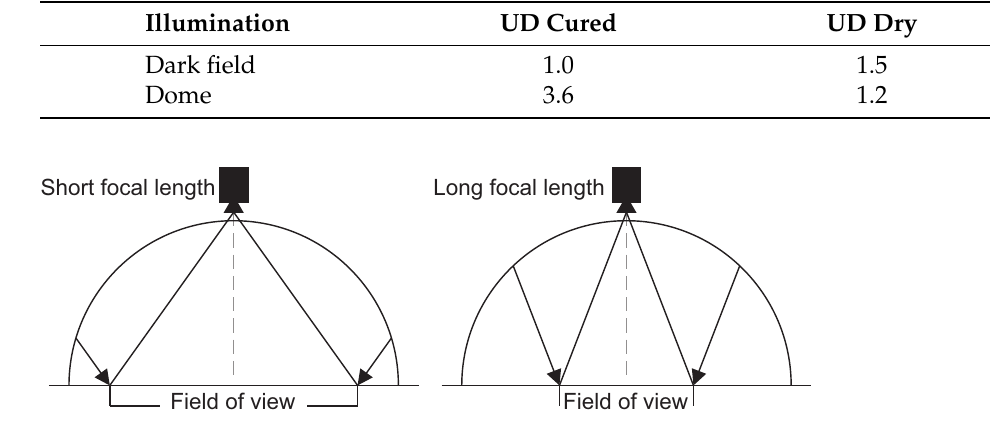
Figure 19. Schematic for demonstrating the greater presence of specular reflection for shorter focal lengths under dome